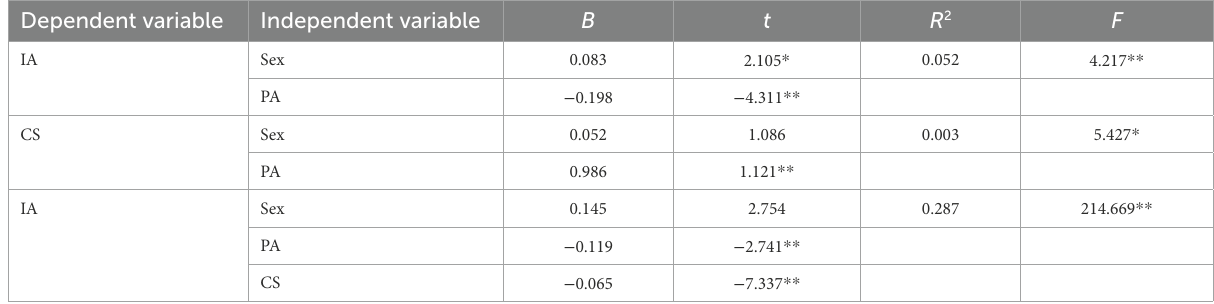
TABLE 5 Regression analysis results.